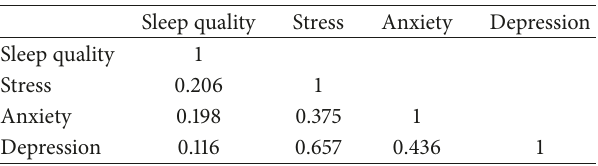
Table 4: Results of partial correlation between sleep quality, stress, anxiety, and depression.